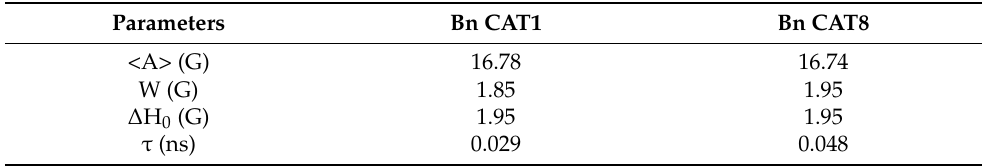
Table 7. EPR parameters for CAT1 and CAT8 probe solutions